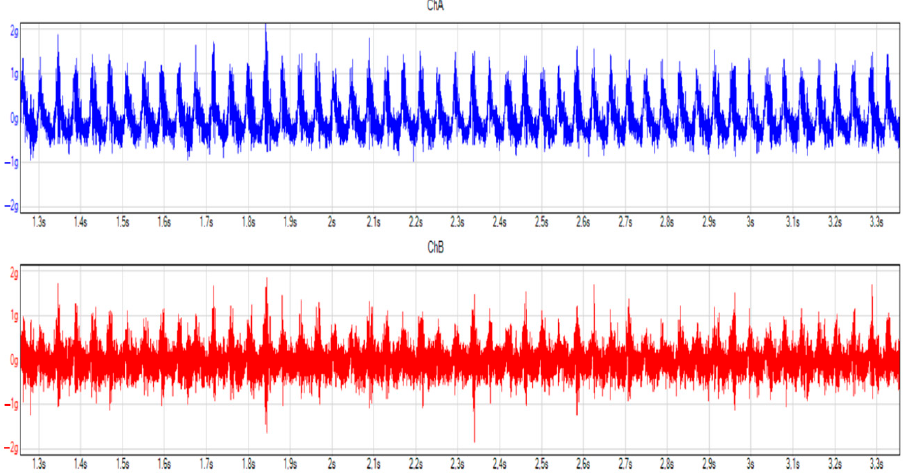
Figure 5. Measurements on the transmission before oil change in the time domain. Blue and red colors mean the different considered and applied channels, during the measurement.